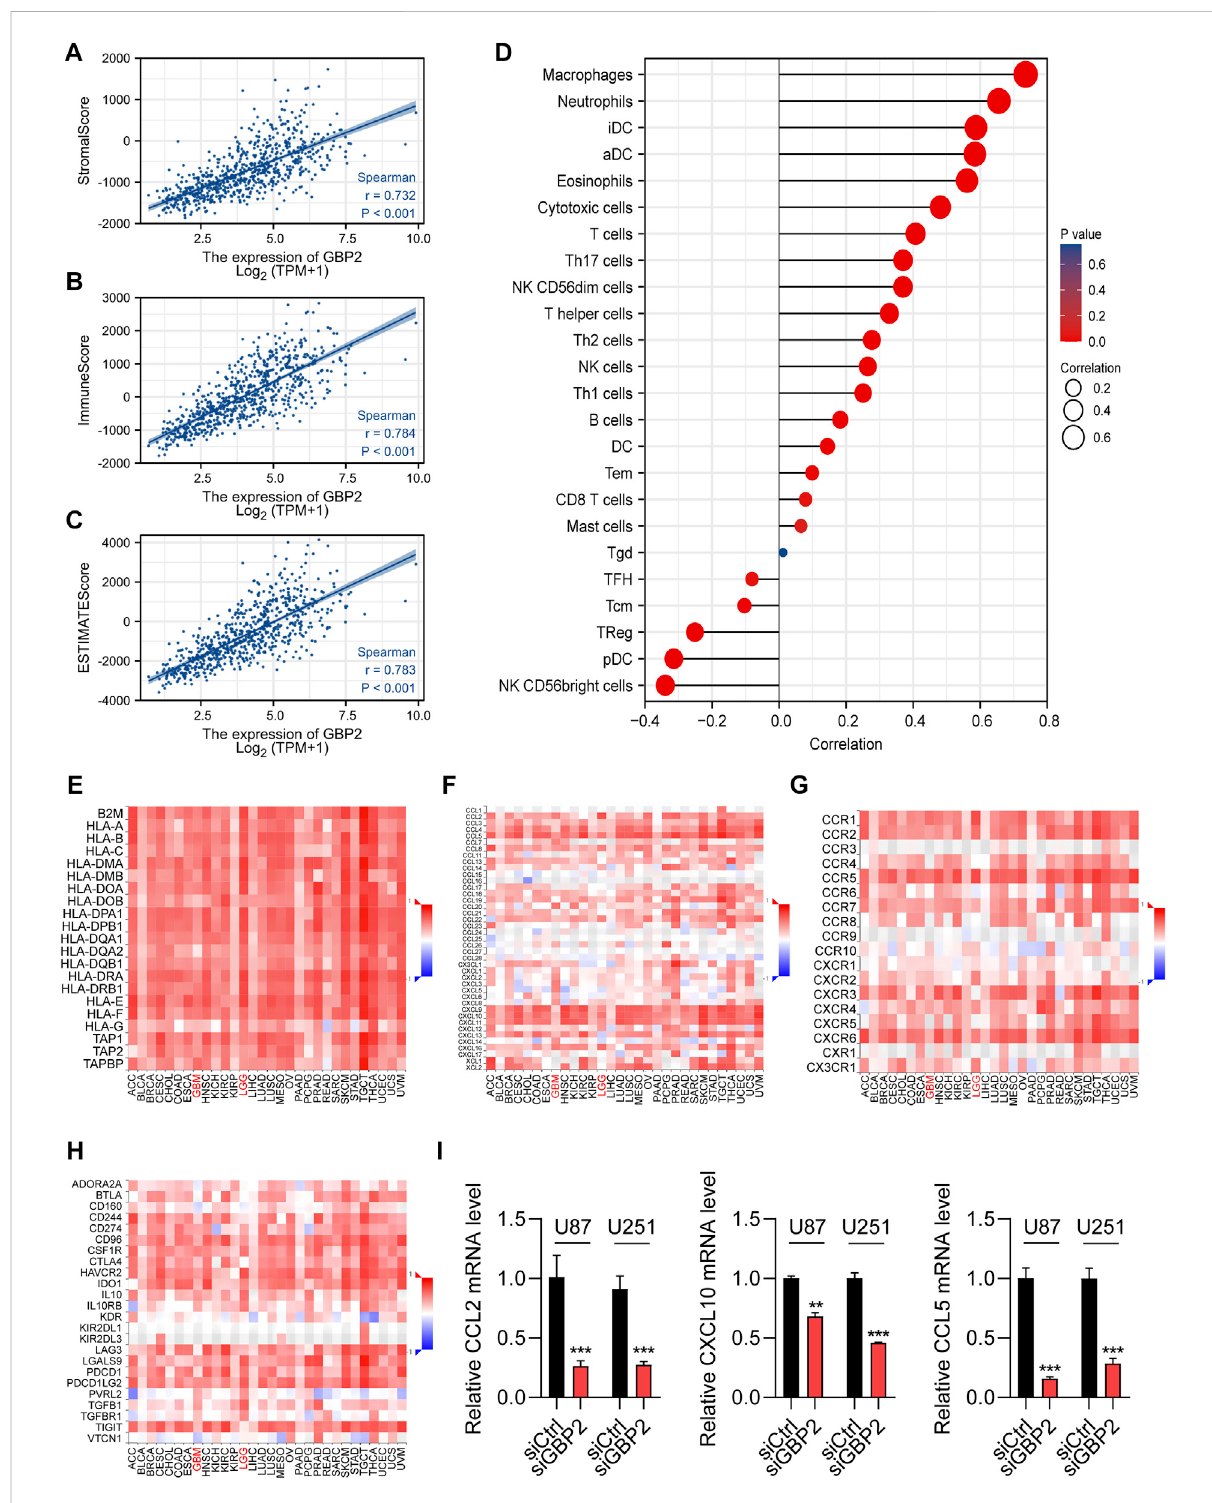
FIGURE 5 GBP2 showed signi fi cant correlations with immune in fi ltration in the glioma microenvironment. (A – C) The Spearman correlations of GBP2 expression with stromal score (A) , immune score (B) , ESTIMAT score (C) . (D) The lollipop graph shows immune cell associations with GBP2 expression. (E – G) The associations of GBP2 expression with antigen presentations genes (E) , chemokines (F) chemokine receptors (G) , and immunecheckpoints (H) . (I) qRT-PCRanalysisofchemokinesgenesinU87andU251cellstransfectedwithsiCtrlandsiGBP2.Theexpressionof indicated genes was adjusted to the expression of β -actin. ** p < 0.01. *** p <